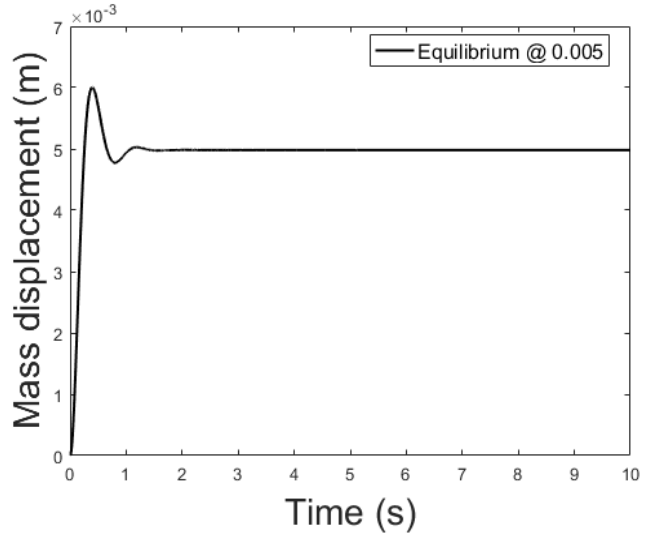
. , , and x 0 = 0 m/s, ψ = 0 Wb and 𝑥𝑥 0 = 0 𝑚𝑚 𝑥𝑥 0 ̇ = 0 𝑚𝑚 / 𝑠𝑠 ψ = 0 Wb